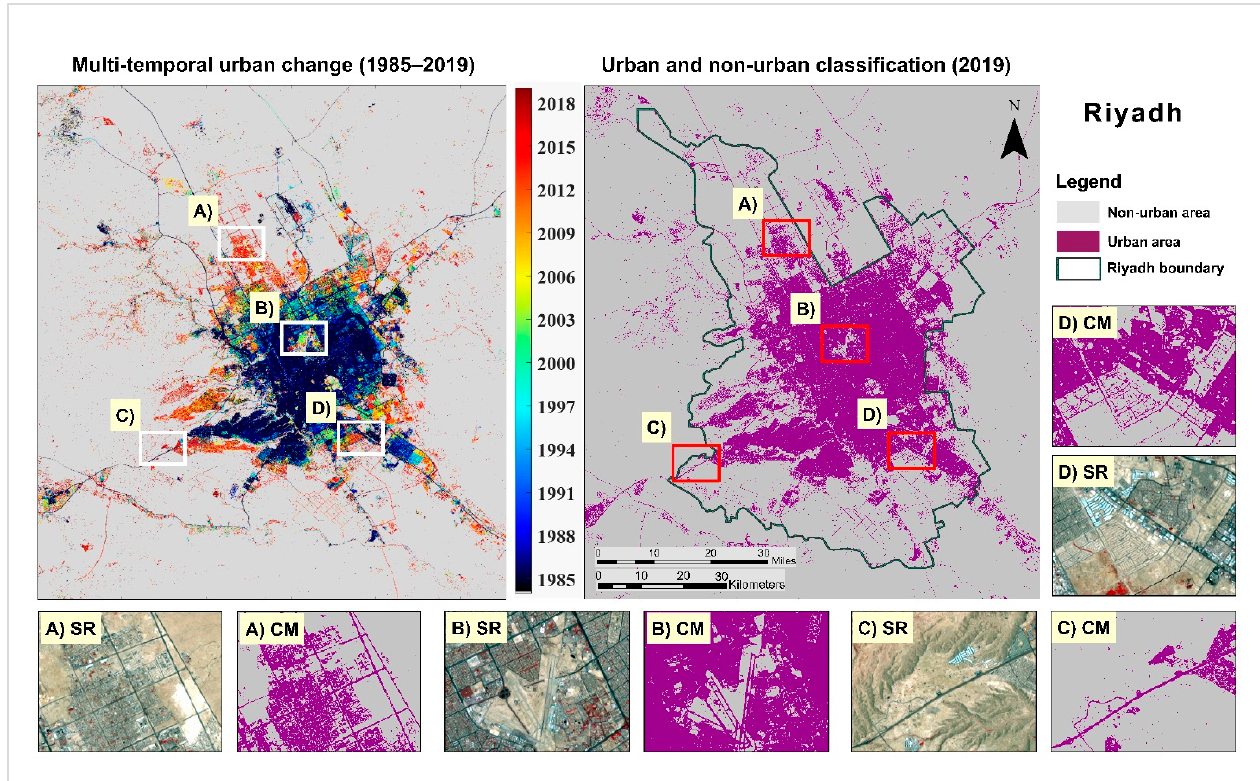
Figure 10. Multi-temporal urban change map (1985–2019) and urban and non-urban classifications in 2019 in Riyadh. Both include surface reflectance (SR) and classification map (CM) samples.